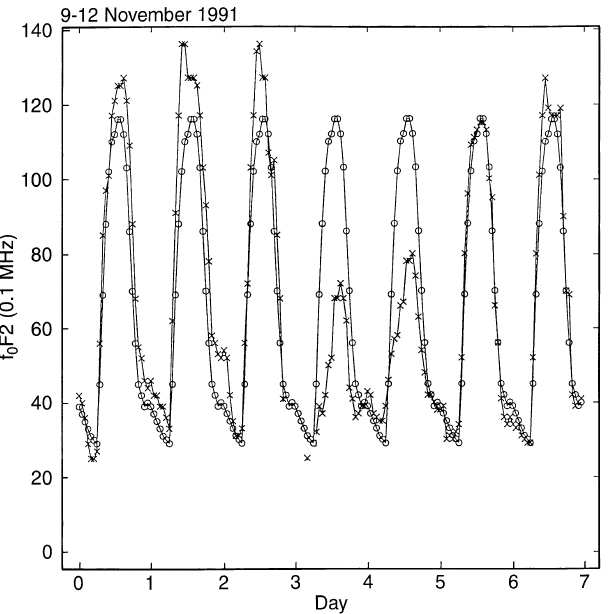
Fig. 1. A typical storm-time behaviour of F2 layer critical frequency, f o F2 , observed at Slough. The crosses are the hourly values observed on 6–12 November 1991, the open circles show the diurnal variation of the monthly median values. The former minus the latter is here termed (cid:100) f o F 2